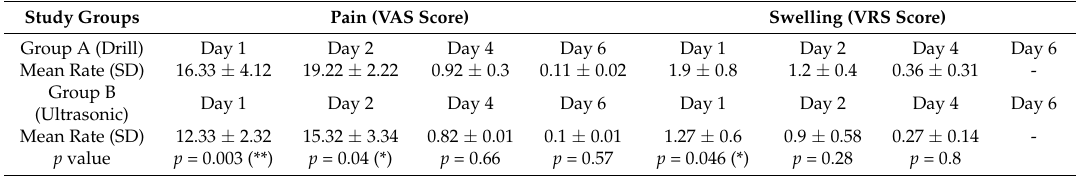
Table 1. Summary of recording of VAS score and swelling score at different times after surgery. The VAS pain score and swelling score (VRS) were significantly decreased in the ultrasonic surgery group.